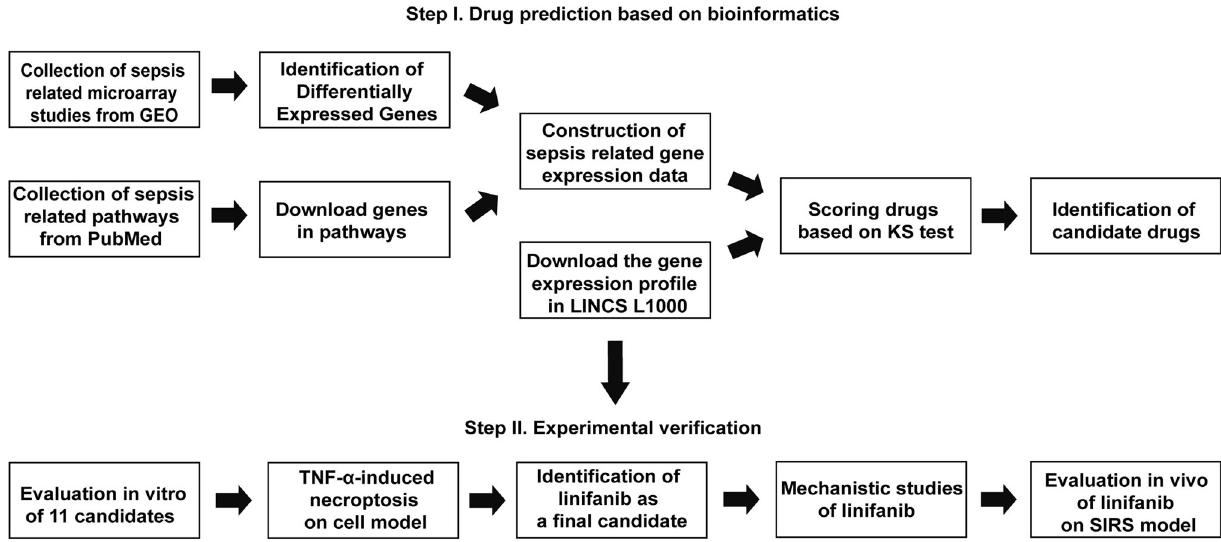
Fig. 1 Experimental design. For virtual screening of sepsis drugs, sepsis-related signaling pathways and datasets were retrieved from a public database. DEGs were extracted from sepsis-related microarray data from GEO. Sepsis-related gene expression data and gene expression pro fi les in the L1000 database were used to calculate therapeutic scores to obtain top candidate compounds. In experimental validation, FDA- approved drug linifanib was shown to have therapeutic effects in cellular and animal models of